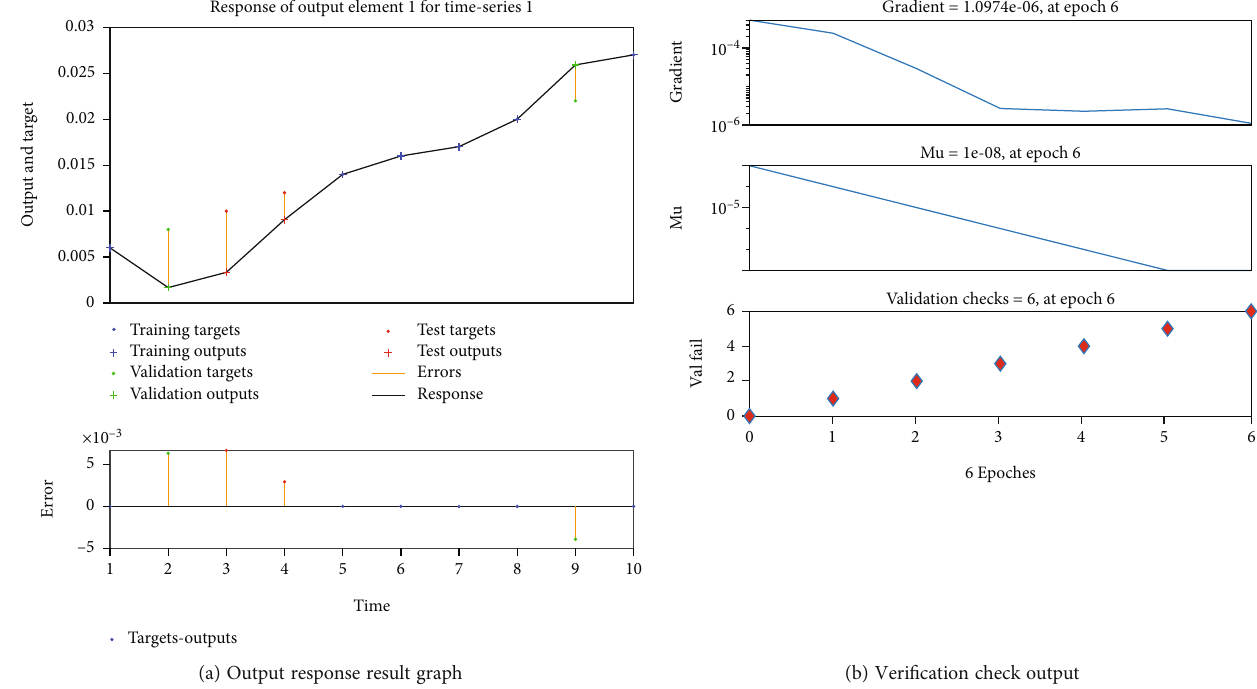
Figure 9: Model result